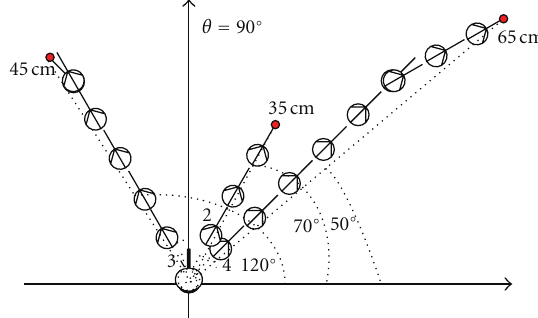
Figure 5: Experimental robot scenario.